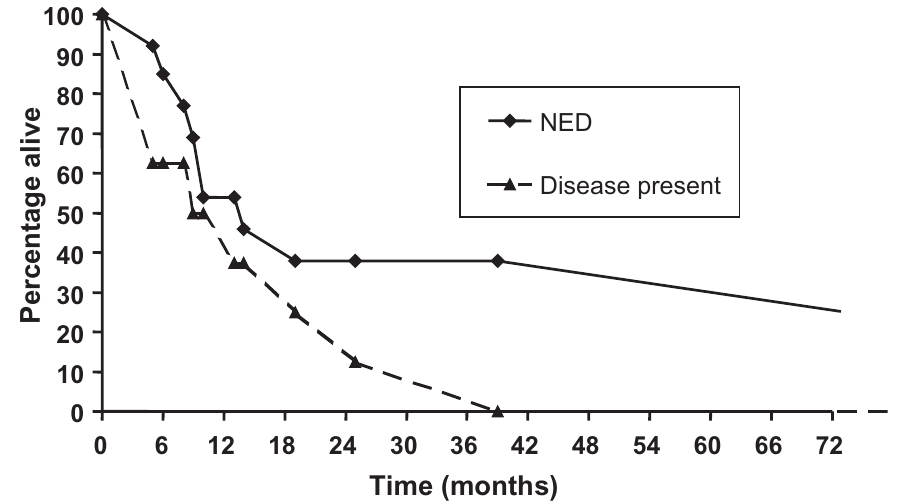
Fig. 2. Kaplan–Meier survival curves of survival according to disease status. NED, no evaluable disease; P ¼